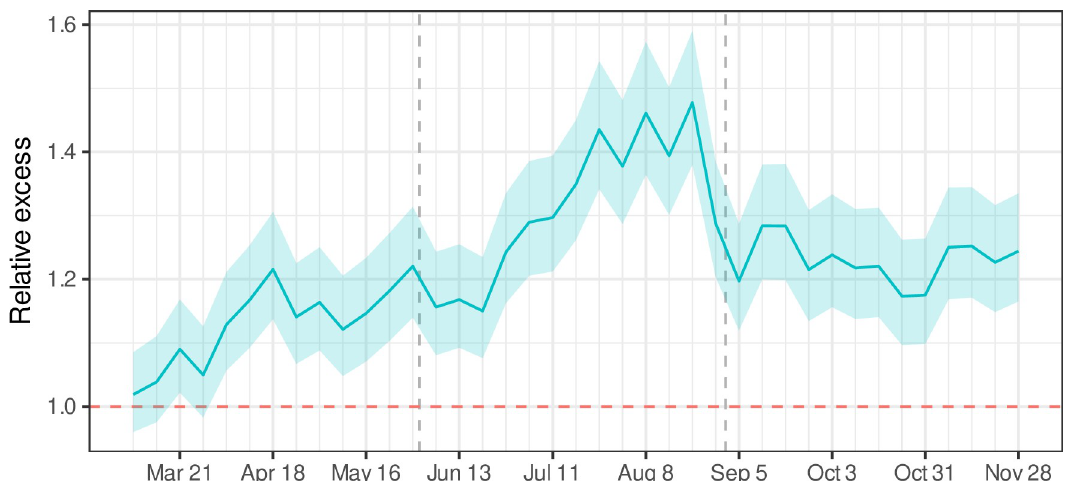
Fig 1. Relative excess mortality among Californians 18–65 years of age, March through November 2020. The dashed vertical lines separate the first 3 quarters of the first year of the COVID-19 pandemic. The quarters roughly correspond to major policy decisions, after accounting for lags from policy decisions to infection to death. The first quarter corresponds to a period of sheltering in place, the second quarter corresponds to a period of reopening, and the third quarter corresponds to a period of business closures.